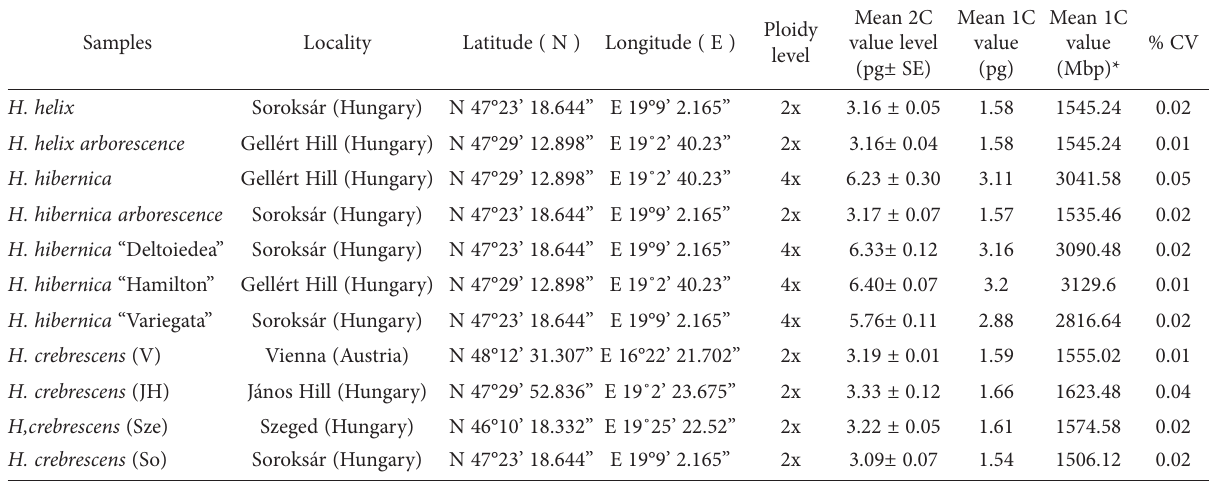
Table 1. Samples, locality and determination of genome size and ploidy level.